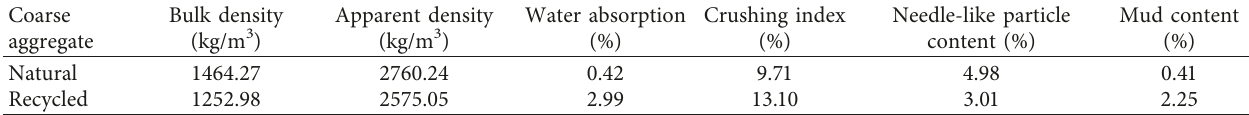
Table 1: Physical properties of RCA and NCA.